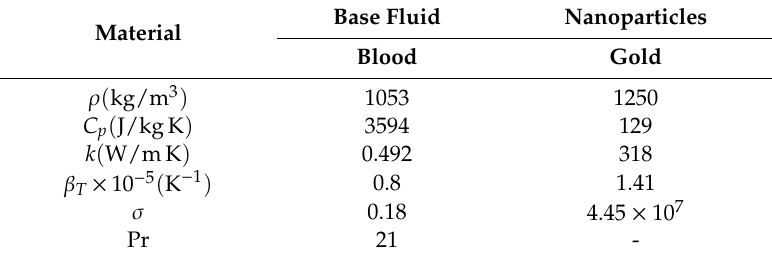
Table 1. Numerical values of base fluid and solid material nanoparticles